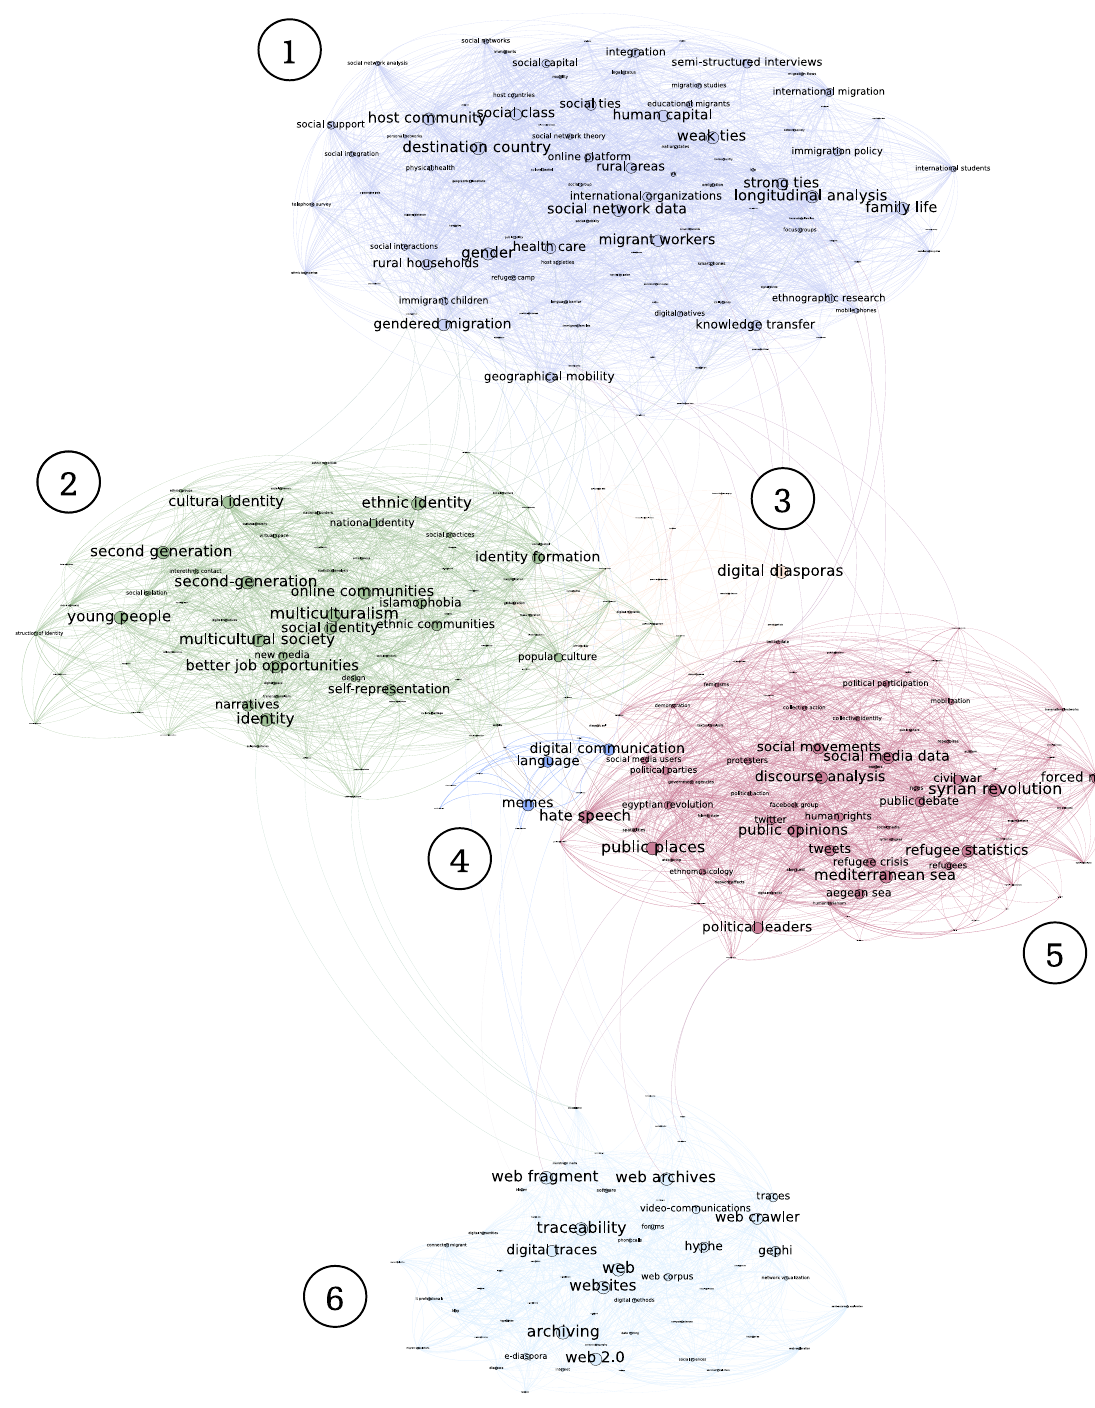
Fig. 1 Map of the 1562 publications related to the digital diasporas and extracted from the Web of Science using a distributional similarity metric. Generated with Gargantext and spatialized with